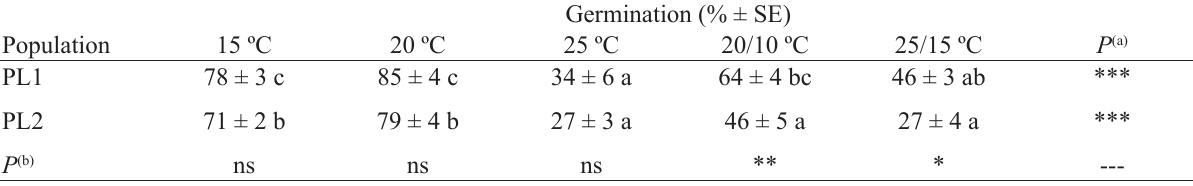
Table 2. Final germination percentage at different temperature regimes for two Plantago lanceolata populations. Mean values within a row followed by the same letters are not significantly different. Abbreviations are: P (a) : For each population, significance level among the final germination percentages from temperatures; P (b) : For each temperature, significance level among the final germination percentages from populations; *** P < 0.001; ** P < 0.01; * P < 0.05; ns, not significant.